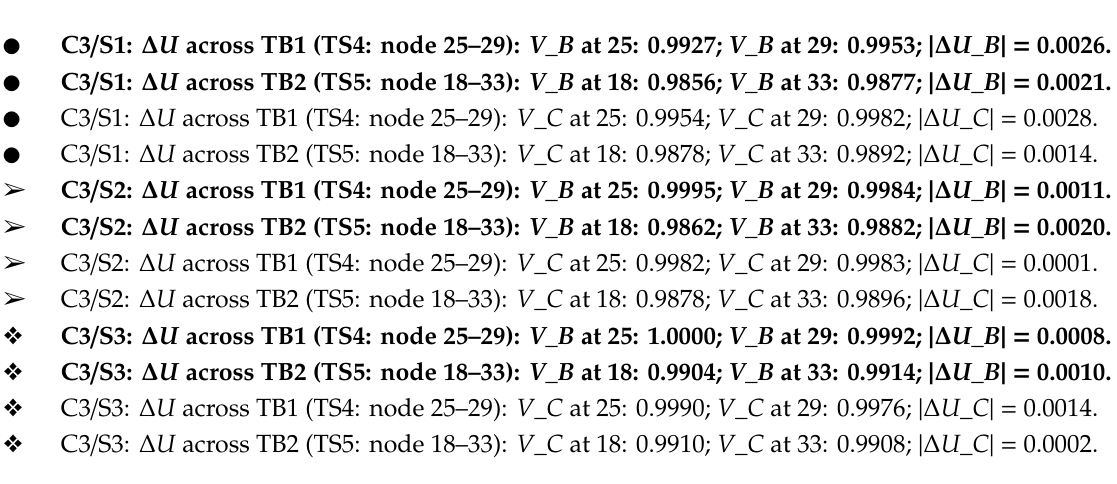
Figure 8. Case 3 for 33-bus MDS: All DGs are type-2 and operating at 0.85 ± 3% PF ( a ) VSAI_B trend, ( b ) V_B profile trend as feasible solution of VSAI_B and calculated V_C profiles. The comparative voltage difference across tie-line branches is indicated in terms of V_B and V_C values in (P.U). The V_B values are highlighted for the purpose of differentiation in contrast to V_C values.